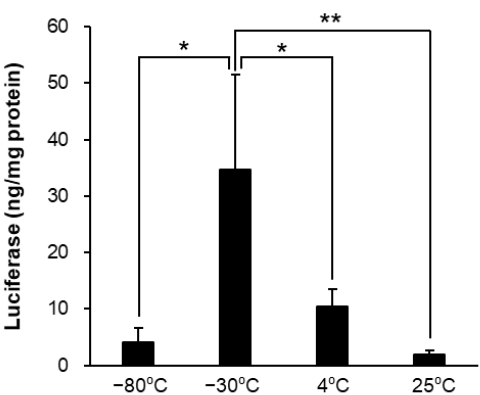
Figure 1. Effects of the storage temperature for in vitro luciferase assay. The mRNA-LNP storage was preserved at −80, −30, 4, and 25 °C for 7 days and thawed. Firefly luciferase expression in HepG2 cells was measured post 24 h adding of each mRNA-LNPs. Data are represented as mean + S.D. ( n = 3). * p < 0.05, ** p < 0.01 indicate significant differences (Tukey’s test).